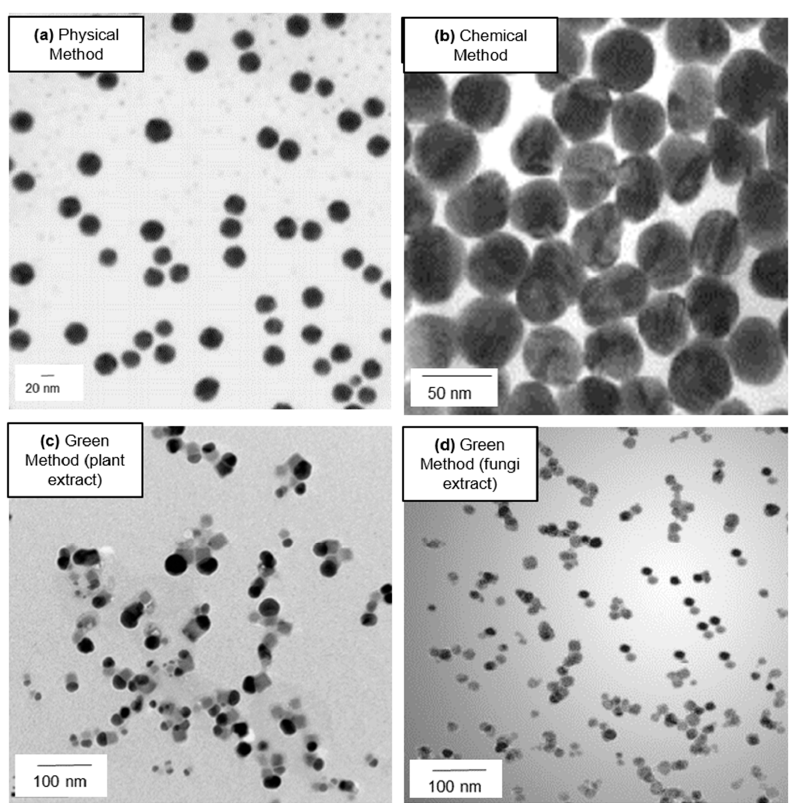
Figure 2. Representative TEM images of Ag NPs synthetized by different synthetic routes: ( a ) Ag NPs (9.4 ± 5.9) nm obtained by 532 nm laser ablation of a Ag rod using 60 mJ/pulse at 1.0 × 10 − 3 M